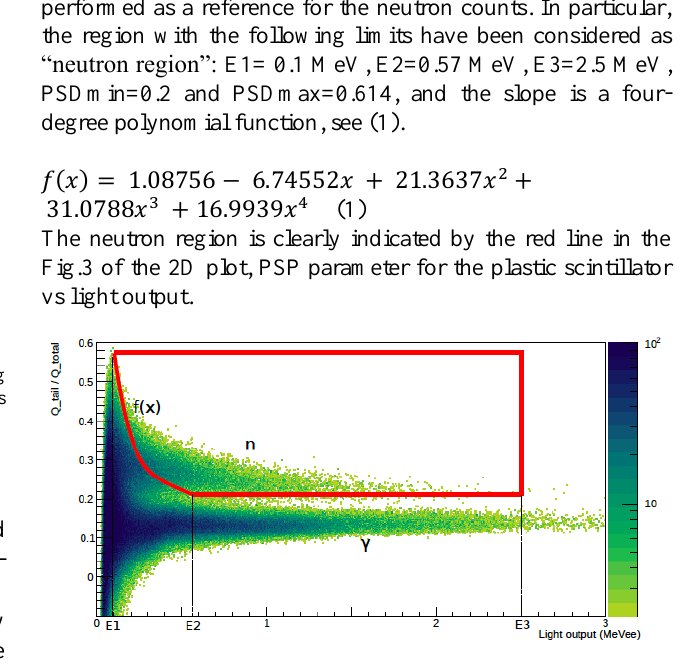
Figure 3: 2D-PSD of a 252Cf source, with the neutron contoured region (red line). Using the Ej-2763”x5”, the RedPitaya digitizer and the PMT model H6559.